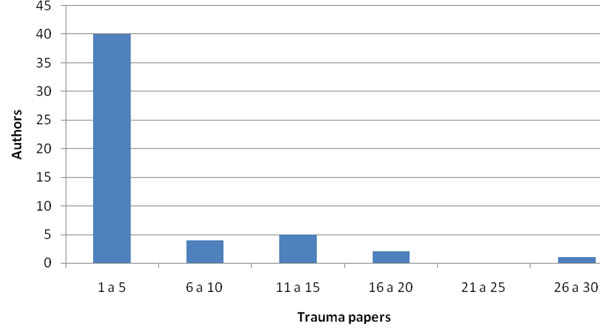
Number of papers in trauma per authors.